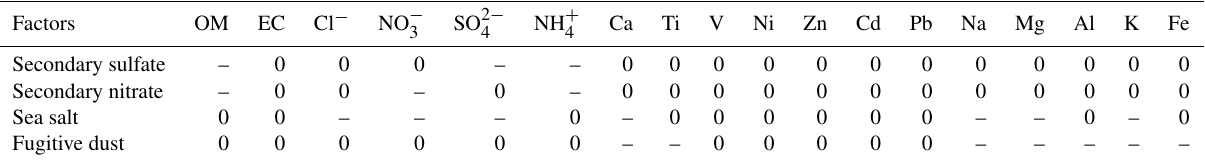
Table 4. The constraints of factor species for ME-2 modeling.